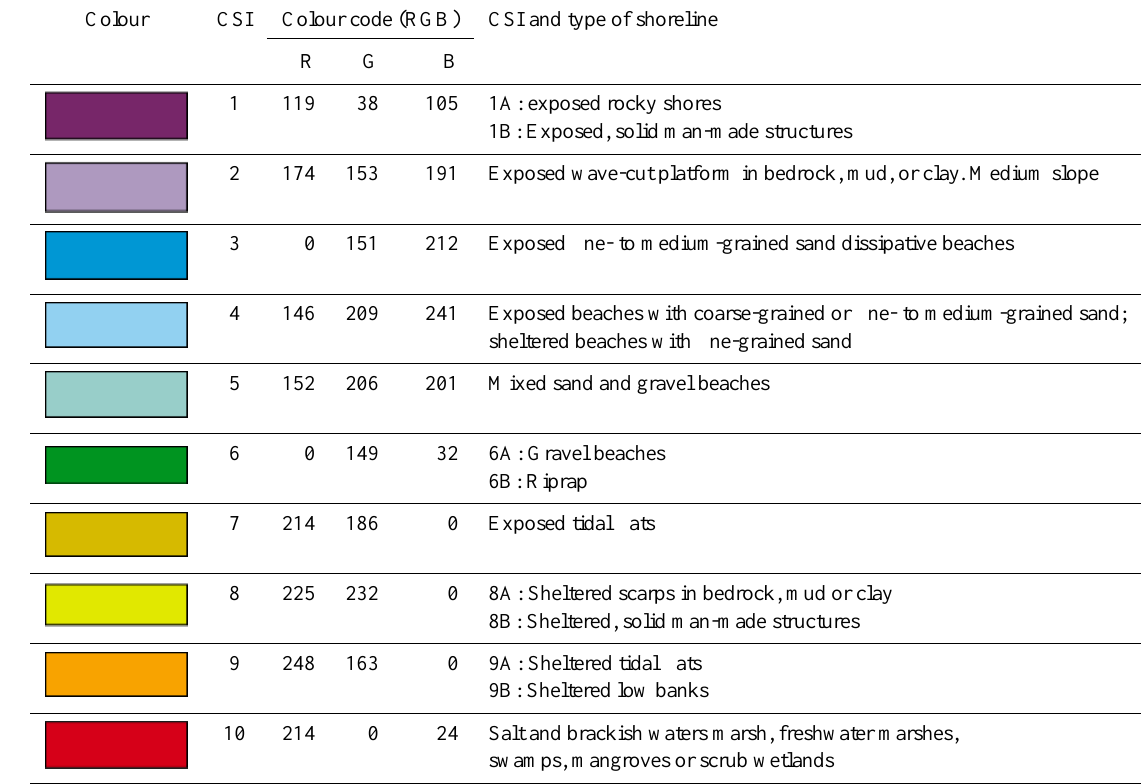
Table A1. Classes used for coastal sensitivity index (CSI).